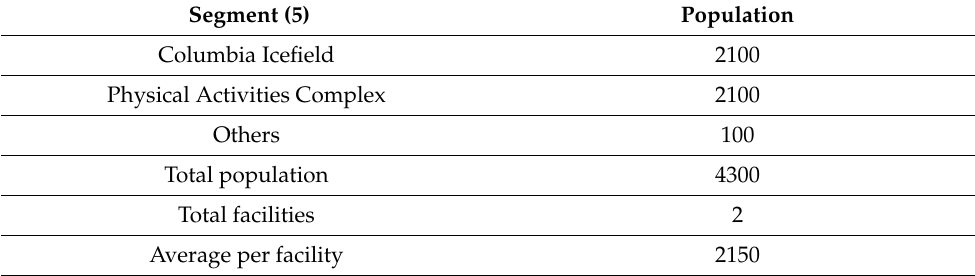
Table 7. Descriptive Statistics for Athletic Buildings.